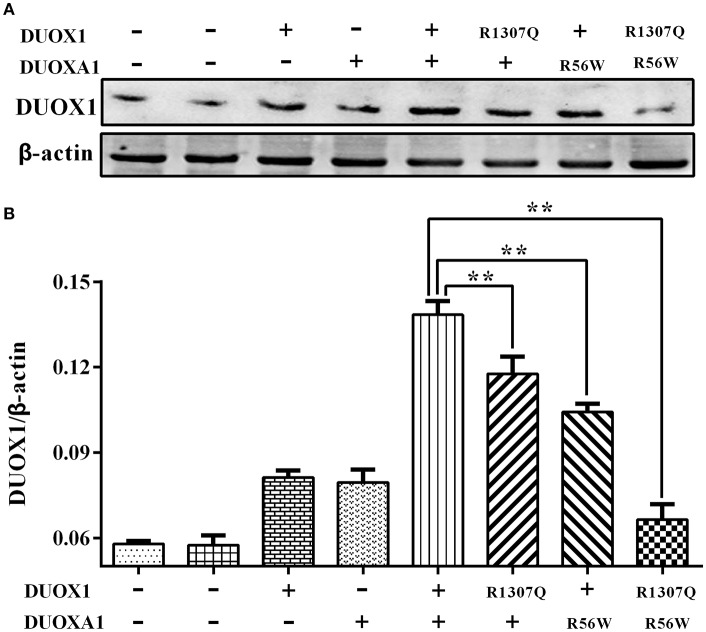
Western blot analysis of the DUOX1 protein expression under various indicated vector transfections. (A) Representative presentation of the gel results. The DUOX1 protein level was highest in the group with both wild-type DUOX1 and DUOXA1 expression vectors, while the group transfected with both p.R1307Q mutant and p.R56W mutant had the least expression level. (B) Densitometric measurement of DUOX1 protein expression. The results are presented as the ratio of DUOX1/β-actin, corresponding to (A). Primary antibodies against DUOX1 was used at a 1:250 dilution and Anti-beta-actin, as loading control, was used at a 1:2,000 dilution. Each column represents the mean ± SD of three independent experiments performed in triplicate. **P < 0.01.